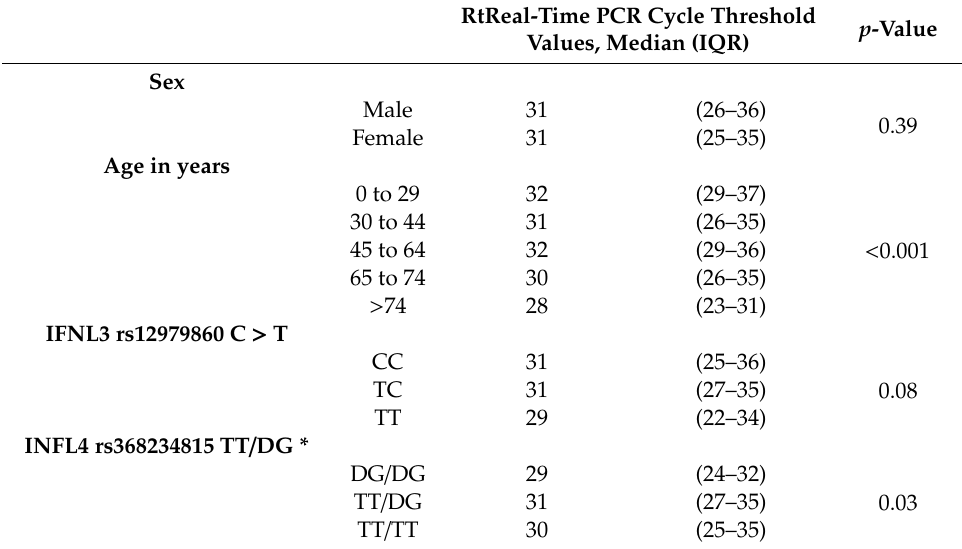
Univariate analyses on RtReal-Time PCR cycle threshold values and investigated independent